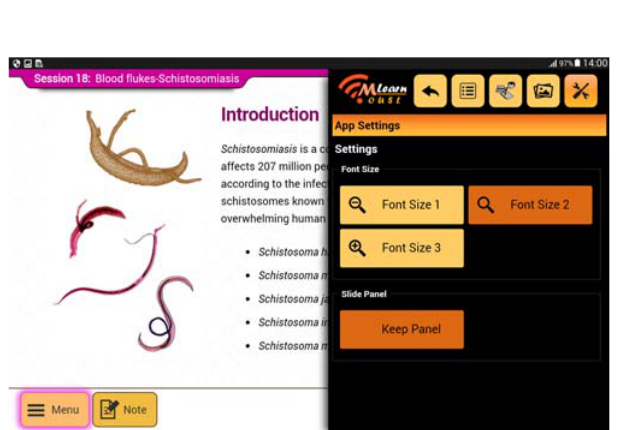
Figure 6. Video integration in the mobile application